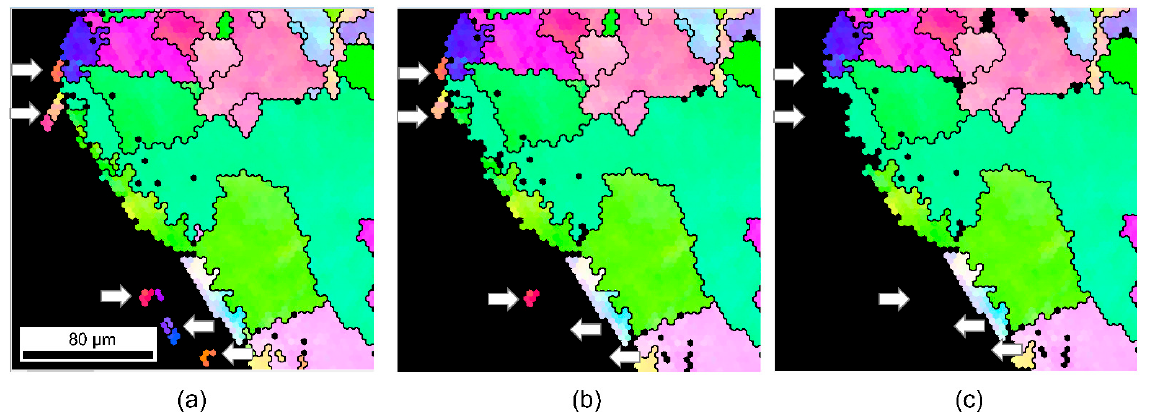
Figure 9. Variations of erroneous grains at points other than the molten mark according to the minimum grain size: pixel sizes of ( a ) 2, ( b ) 5, and ( c ) 10.